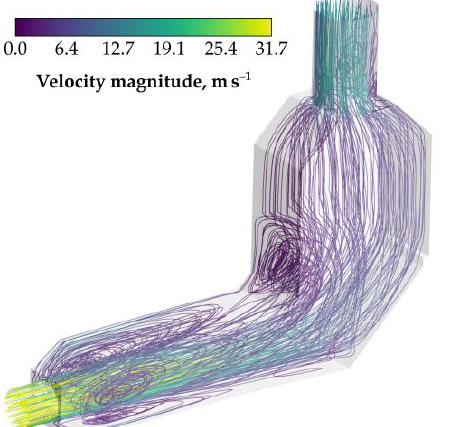
Figure 12. Pathlines in the flue gas duct, which were colored by velocity magnitude. One can see that the flow behind the bend is pushed to one side as indicated in Figure 11 and that there are relatively large recirculation zones present.